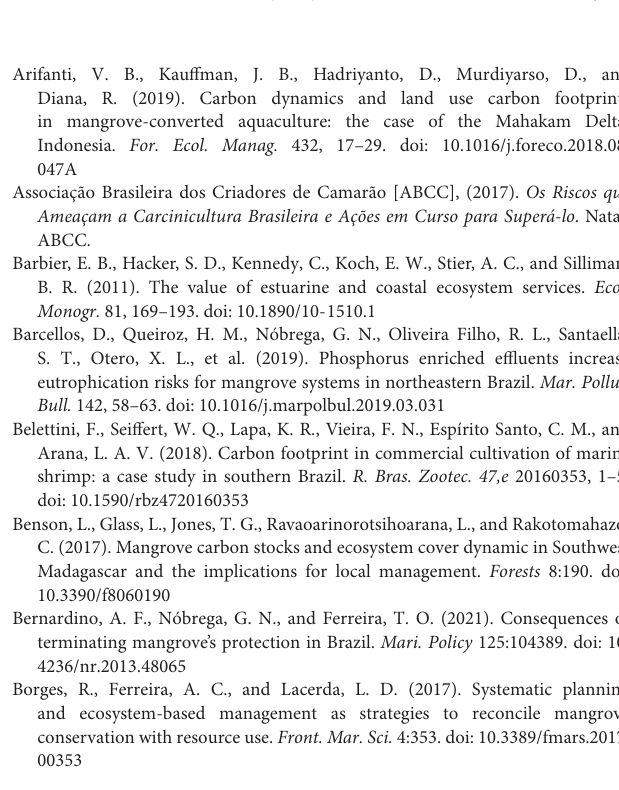
Supplementary Figure 1 | Impact on mangrove forest canopy health by increasing adjacent shrimp farm area. Note that direct conversion of mangroves into ponds is relatively small, but degradation of forest cover is widespread. Jaguaribe River estuary, Ceará State, NE Brazil. Supplementary Figure 2 | Impact on mangrove forest canopy health by increasing adjacent shrimp farm area. Note that degradation areas present NDVI similar to bare soil. Jaguaribe River estuary, Ceará State, NE Brazil. Data from 2003 and 2008 from Marins et al. (2020); and for 2017, estimated in this